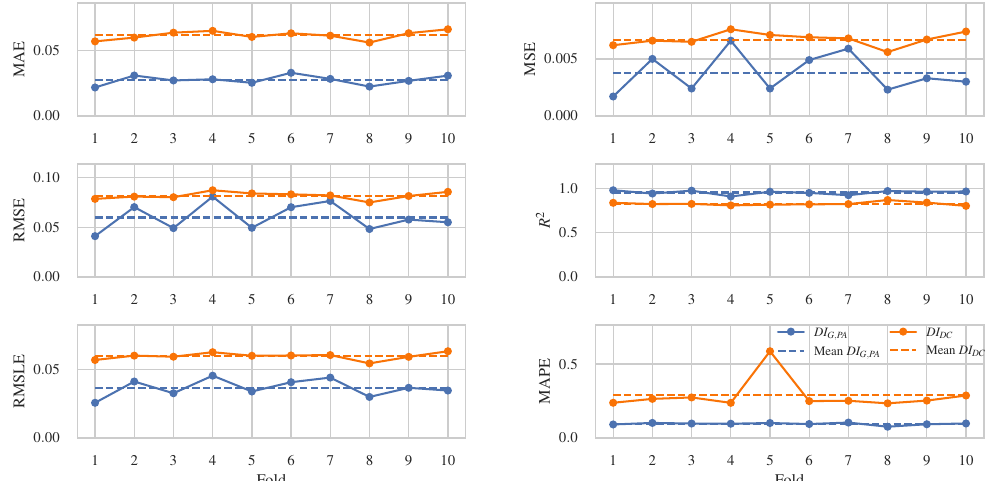
Figure 9. Evolution of performance metrics during 10-fold cross-validation for ETR and GBR algo- rithms in case of DI G,PA and DI DC damage indices,